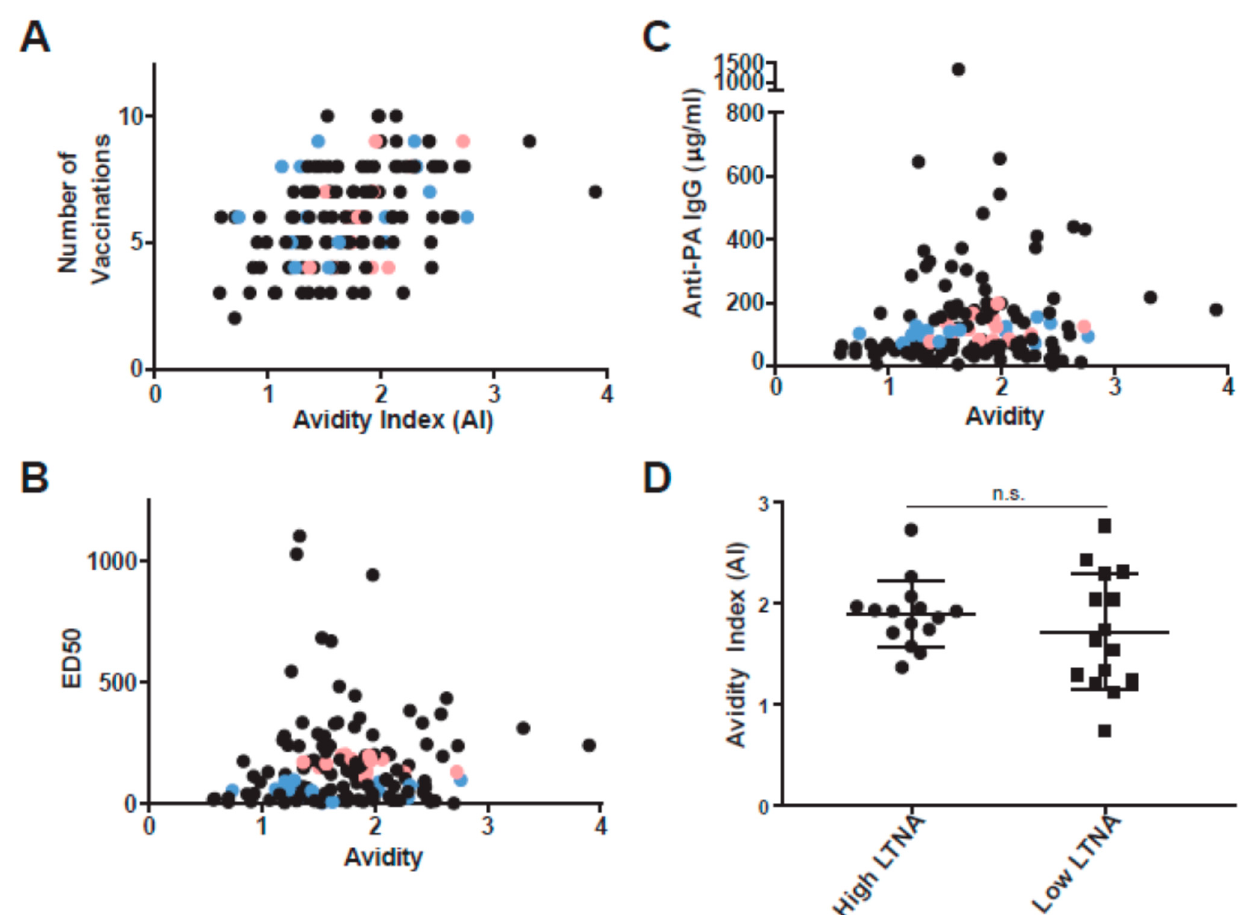
Figure 4. Antibody avidity by thiocyanate elution ELISA. ( A ) Avidity index plotted vs total number of vaccinations in all 144 individuals shows a positive Spearman’s correlation ( r s = 0.475; p s < 0.0001). However, there is no correlation between avidity index and ( B ) ED50 ( r s = 0.114; p s = 0.1761) or ( C ) anti-PA concentration ( r s = 0.154; p s = 0.0667), In panels ( A – C ) the black dots are from the total cohort; from this cohort, data from high neutralizers from the matched cohort are shown in pink while data from low neutralizers are shown in blue. ( D ) In the matched cohort, several low neutralizers have lower avidity indexes than the high neutralizers, but there is no significant difference between the groups (data from high neutralizers are shown as circles, data from low neutralizers are shown as squares).